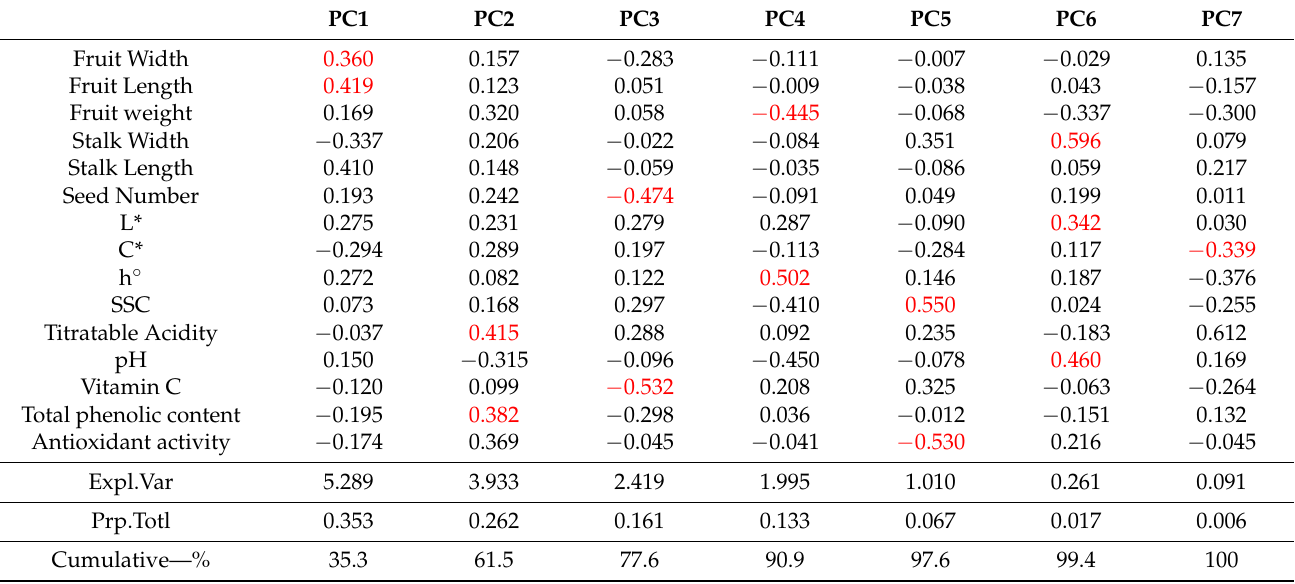
Table 5. Eigenvalues and total variability proportion of principal component (PC) axes for investi- gated